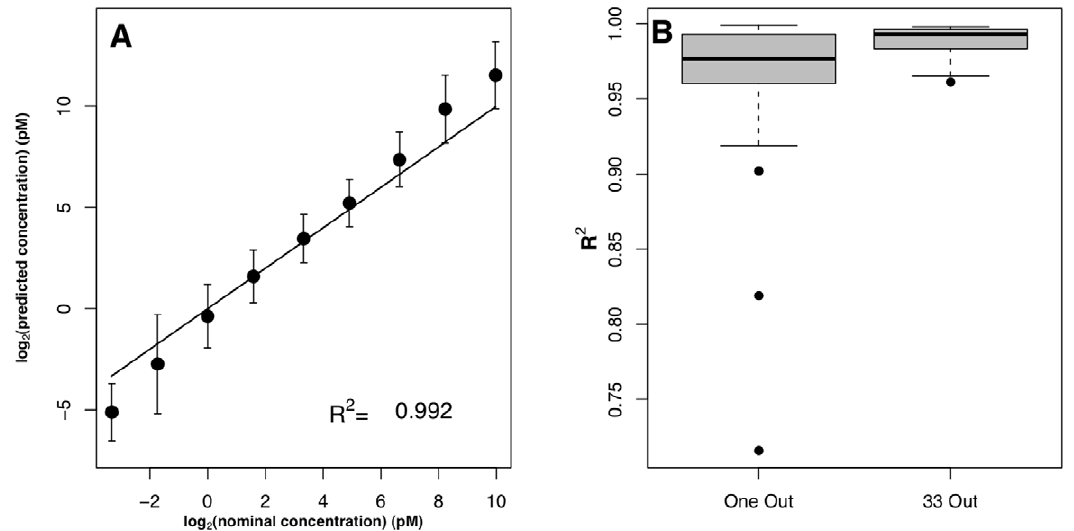
Figure 4. Effect of varying the number of probesets included in the training set on the performance of GLAM. Each Box plot shows the R 2 ( y axis) for 42 choose K ( x axis) of the estimated target concentrations using the Affymetrix U133A control dataset. Each box plot has 42 data points.